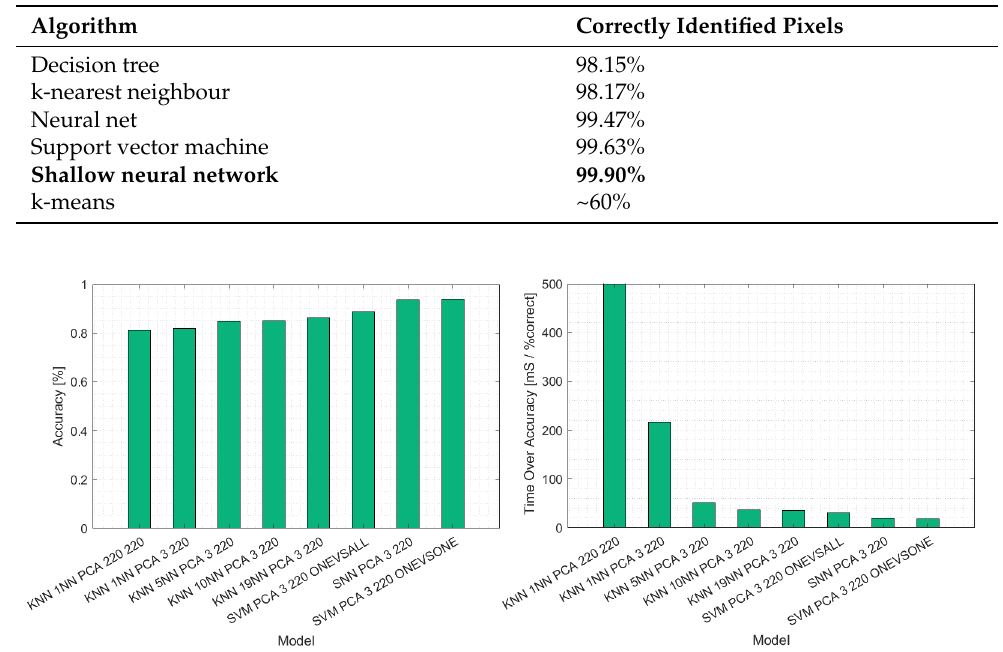
Table 4. Correctly identified pixels and respective machine learning algorithm.